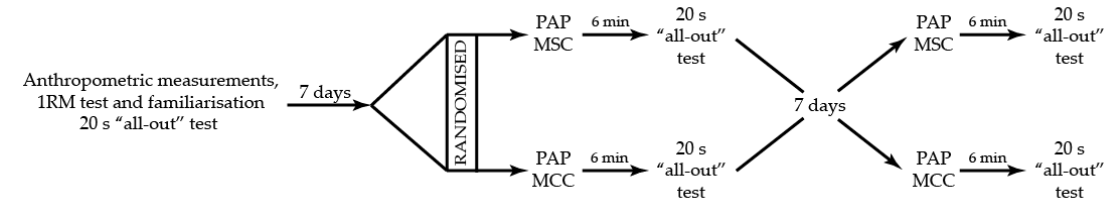
Figure 1. Schematic representation of the study design.